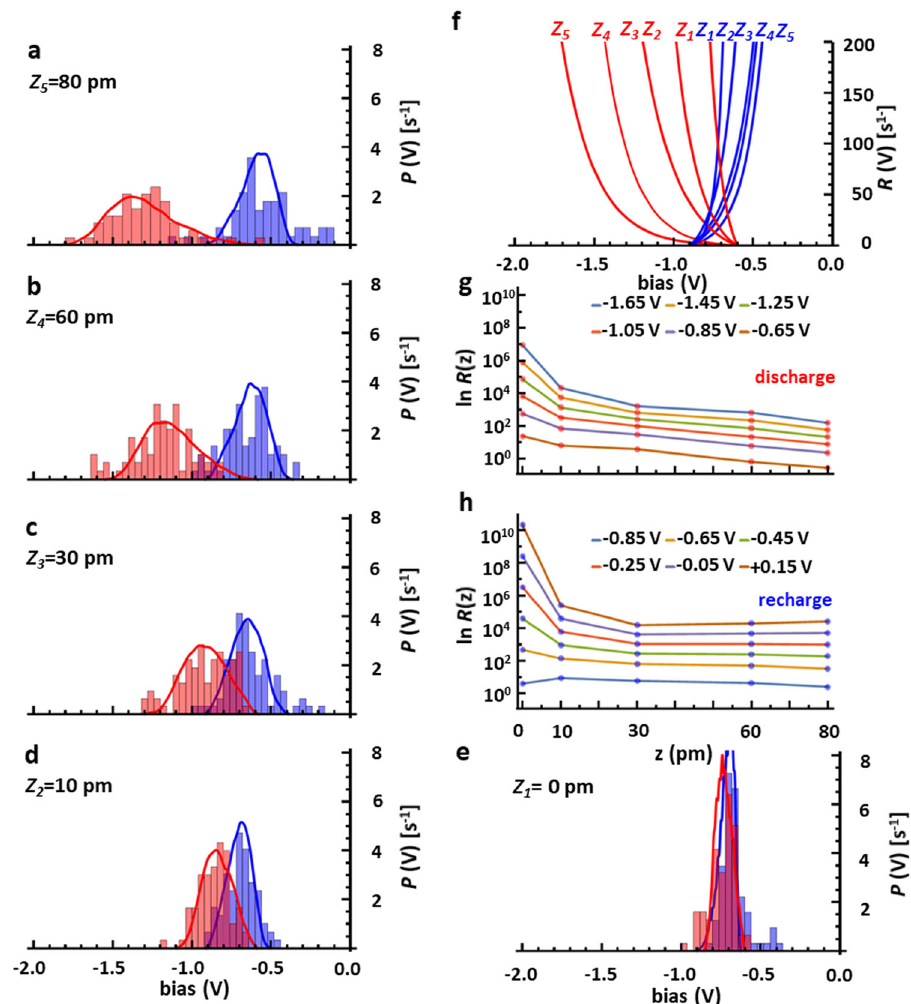
Fig. 4 FC-KPFS measured and simulated probability density distributions and tunnelling rates at 78 K. a – e Measured histograms of the probability density distributions for recharging (blue) and discharging (red) tunnelling transitions at several tip heights as indicated. Solid red and blue lines show MC simulated distributions which provide the best fi t to the measured ones. f Optimised transition rates vs. bias for the fi ve tip heights. g , h ln R as a function of z for discharging and recharging,